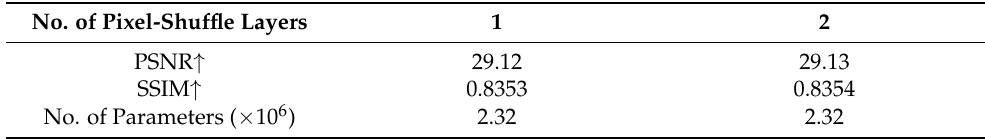
Figure 11. Investigation of the number of Resblocks in the ( a ) alignment and ( b ) up-sampling blocks, respectively. PSNR per iteration on REDS4 dataset. respectively. PSNR per iteration on REDS4 dataset. Table 4. Verification tests to determine the optimal number of pixel-shuffle layers. Each test result shows PSNR (dB), SSIM, and the number of